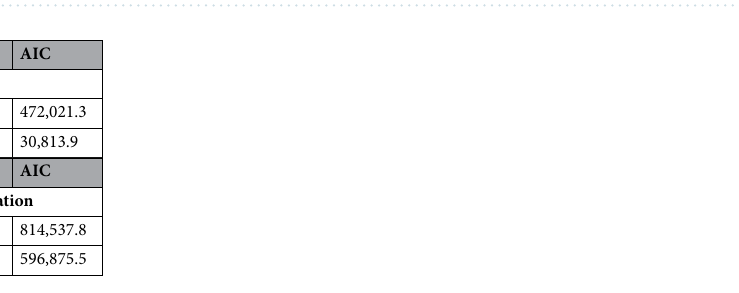
Figure 5. K. pneumoniae ATCC BAA-1705 and BAA-1706 were cultivated in paralell in SLIC. The output mV data from SLIC v7 over 600 min is plotted in ( A ) with the data for the first 120 min of the experiment is shown in ( B ) (one measurement per second with one in 480 points included in the graph). Points represent the mean of three independent measurements and error bars are the standard error of the mean. All data were fitted to the Gompertz and Broken stick equations (Eqs. 1 and 2, respectively). The fitting results are illustrated in ( C,D ). Note from Table 2 that the Broken Stick gave better fittings than the Gompertz equation, as determined by lower AIC values (see Table 2).